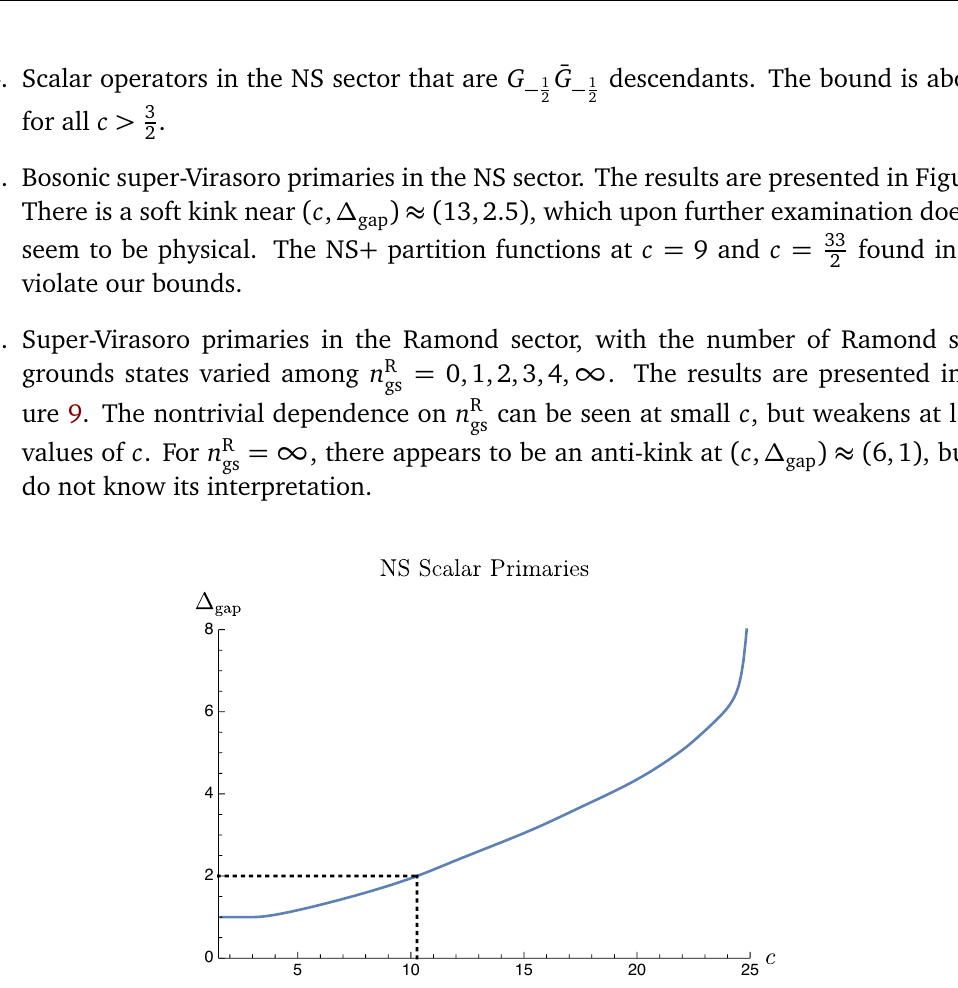
Figure 5: Upper bounds on the gap in the NS spectrum of scalar super- Virasoro primaries, as the central charge is varied up to c = 25. The range of c in which the bound is below 2, marked by the dashed lines, indicates the necessary existence of a supersymmetry breaking relevant